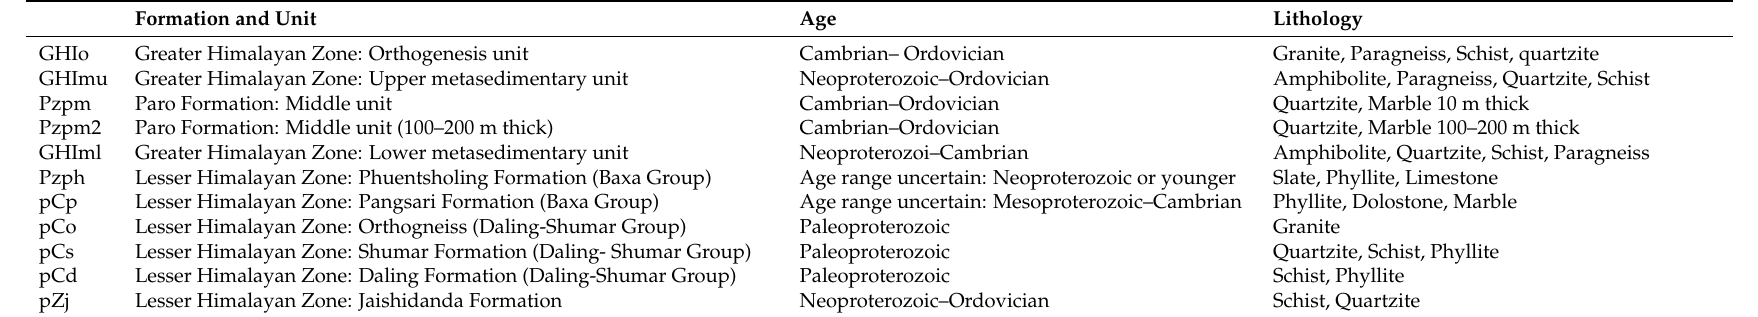
Table 1. Lithology and age of geological formations in the study area